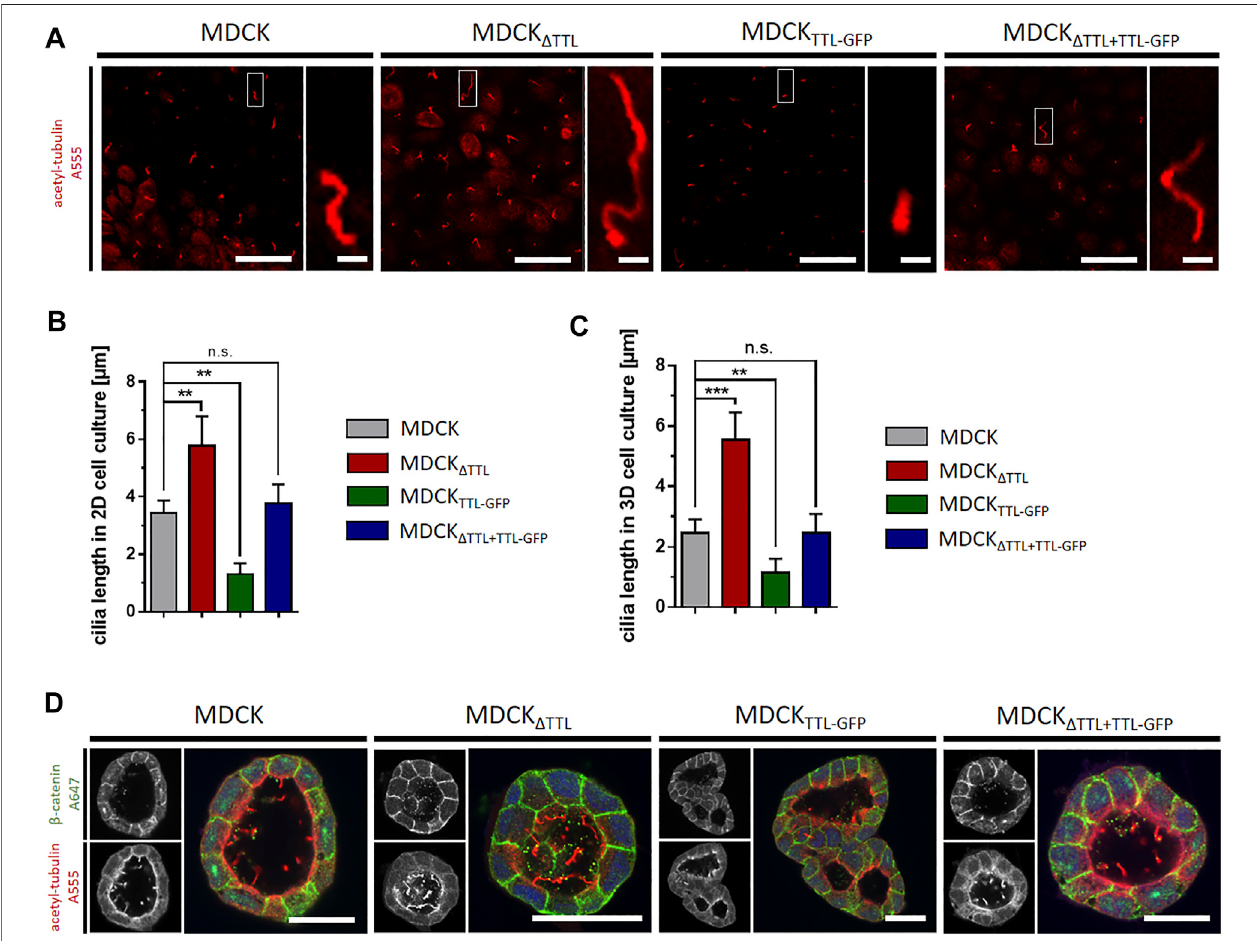
FIGURE 7 | Primary cilia-length is affected by modulation of TTL-expression in 2D- and 3D-cell culture models. (A) The length of primary cilia immunostained with antibodies directed against acetylated tubulin (red) was measured from cells grown in monolayers on PET- fi lters. Scale bars: overviews, 20 μ m; insets, 2 µm. (B,C) Quanti fi cation of primary cilia length in cells grown in monolayers on fi lters (B) and in cells grown in matrigel embedded cysts (C) . Mean ± s.d., n = 3. Statistical signi fi cancewastested usingone-wayANOVA withDunnet ’ scomparison (n.s.,notsigni fi cant;** p < 0.01,*** p < 0.001). (D) MDCK,MDCK Δ TTL ,MDCK TTL-GFP and MDCK Δ TTL+TTL-GFP cells were cultured in Matrigel for 7 days. Cysts were stained with antibodies directed against β -catenin (green) and acetylated tubulin (red). Scale bars: 30 µm.